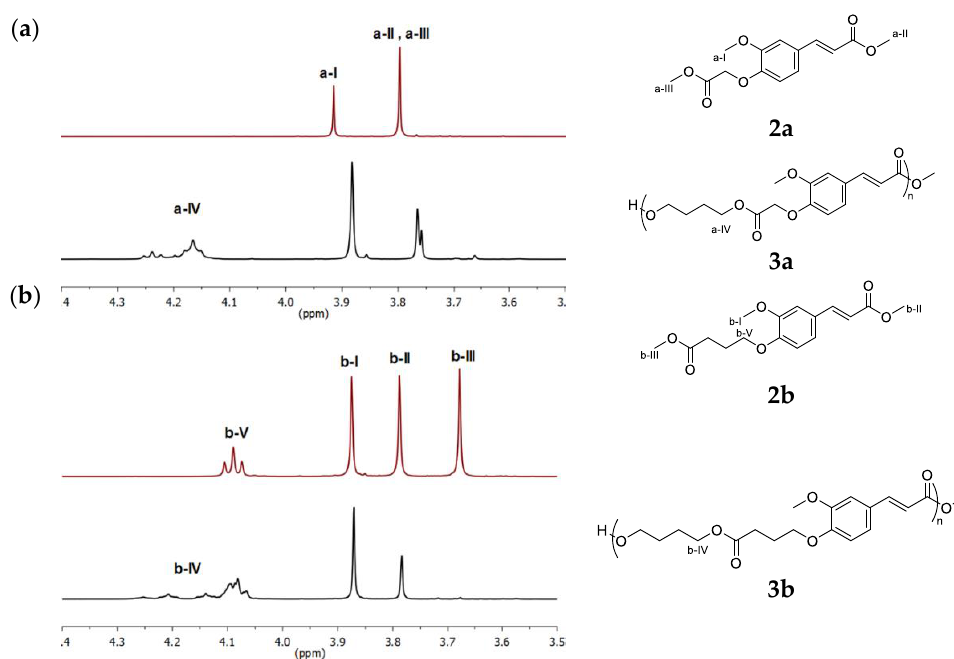
Figure 1. NMR spectra in CDCl 3 of the ferulic-based diesters and their corresponding polyesters: ( a ) 2a and 3a ; ( b ) 2b and 3b . ( a ) 2a and 3a ; ( b ) 2b and 3b Table 1. Main properties of the enzymatically synthesized polyesters.